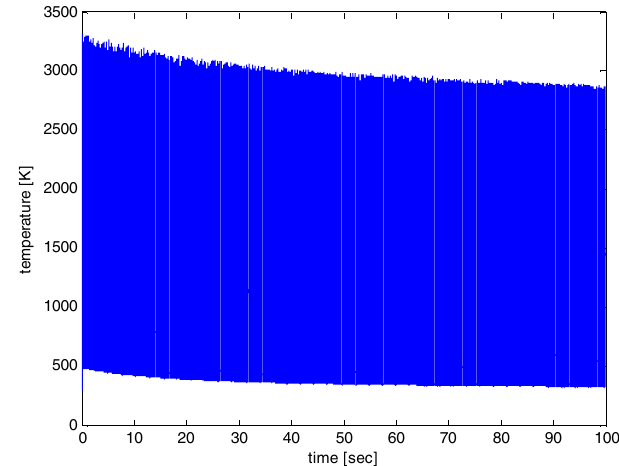
FIG. 3. (Color) Deformation of a temperature field in a target of BNL linac, caused by the decreasing of the foil thickness due to its